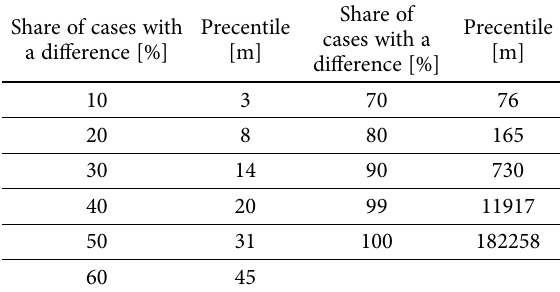
Table 2. Difference in the accident location data of cases obtained from the MTPL database